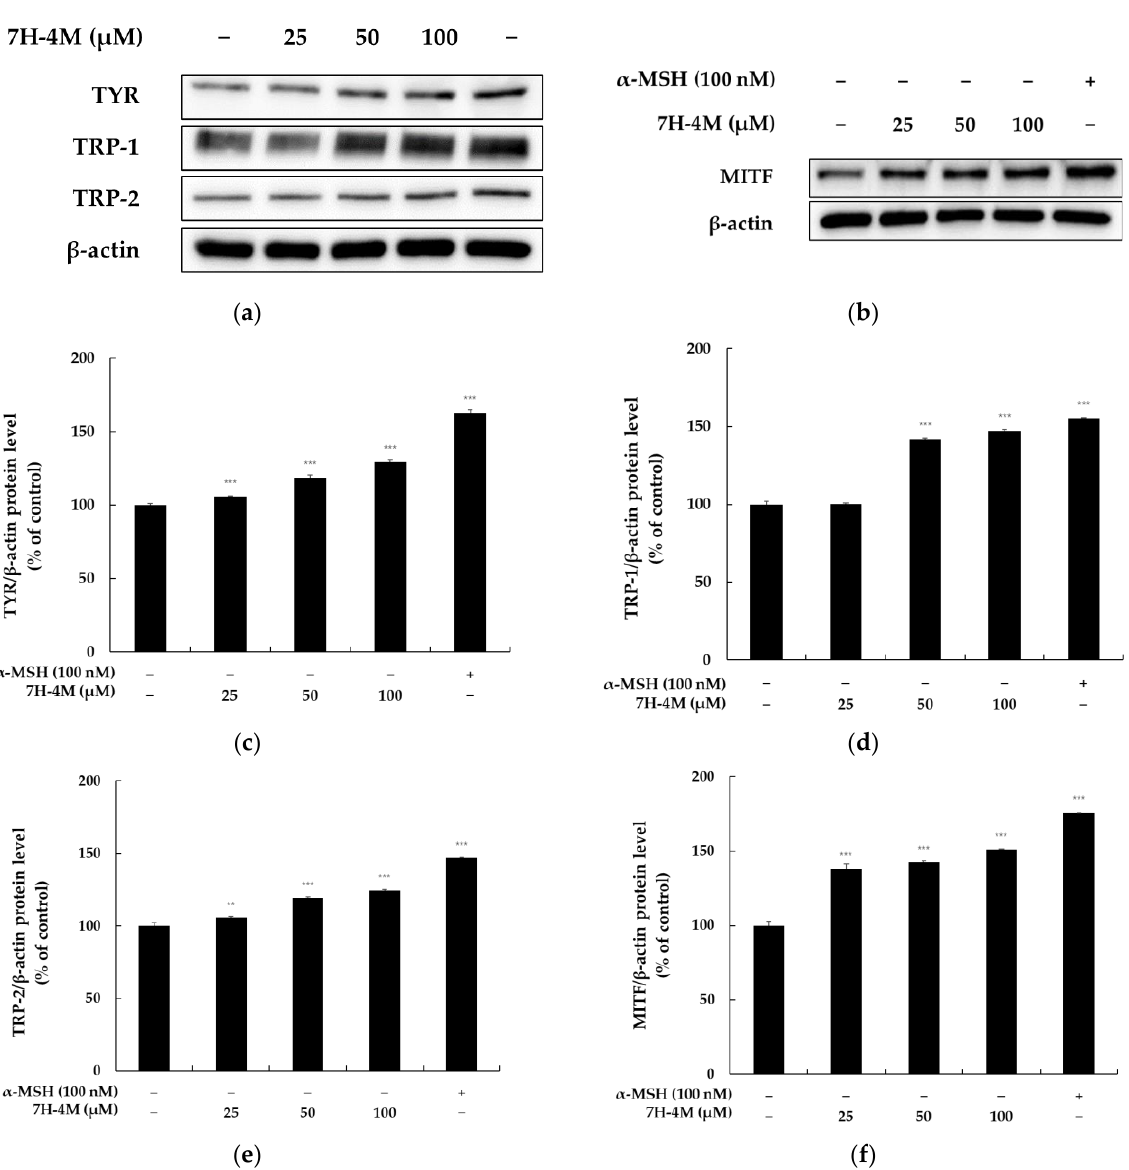
Figure 4. The effect of 7H-4M on the melanogenesis-related protein expression of B16-F10 cells. The cells were treated with various concentrations of 7H-4M for 72 h and were collected for protein extraction. The expression levels of tyrosinase (TYR), TRP-1, TRP-2, and MITF were evaluated using a Western blot experiment. ( a,b ) Western blotting results and ( c ) tyrosinase, ( d ) TRP-1, ( e ) TRP-2 and ( f ) MITF protein expression. The protein bands were quantified using ImageJ software, and the intensity values were normalized to the loading control. The untreated cells were considered as